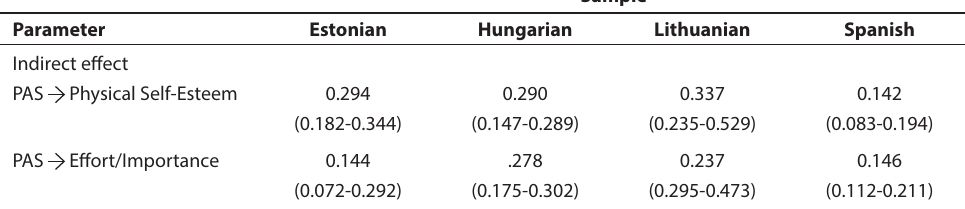
model across the four samples was conducted following the recommendation of Byrne (2010). In terms of the measurement invariance models, a multi-group comparison between the configural model and the models testing for the invariance of measurement weight, structural weight, structural covariances and structural residuals was based on the ΔCFI value which was expected to be 0.01 or less to indicate no difference between the tested models. Goodness-of-fit indices for each model in invariance routine are presented in Table 5. At first, the configural (unconstrained) model was estimated to test whether the pattern of items and factors was feasible across the samples. This model demonstrated a good fit with the data according to the multiple TABLE 4 Indirect Effects of Perceived Autonomy Support on Physical Self-esteem and Effort/importance